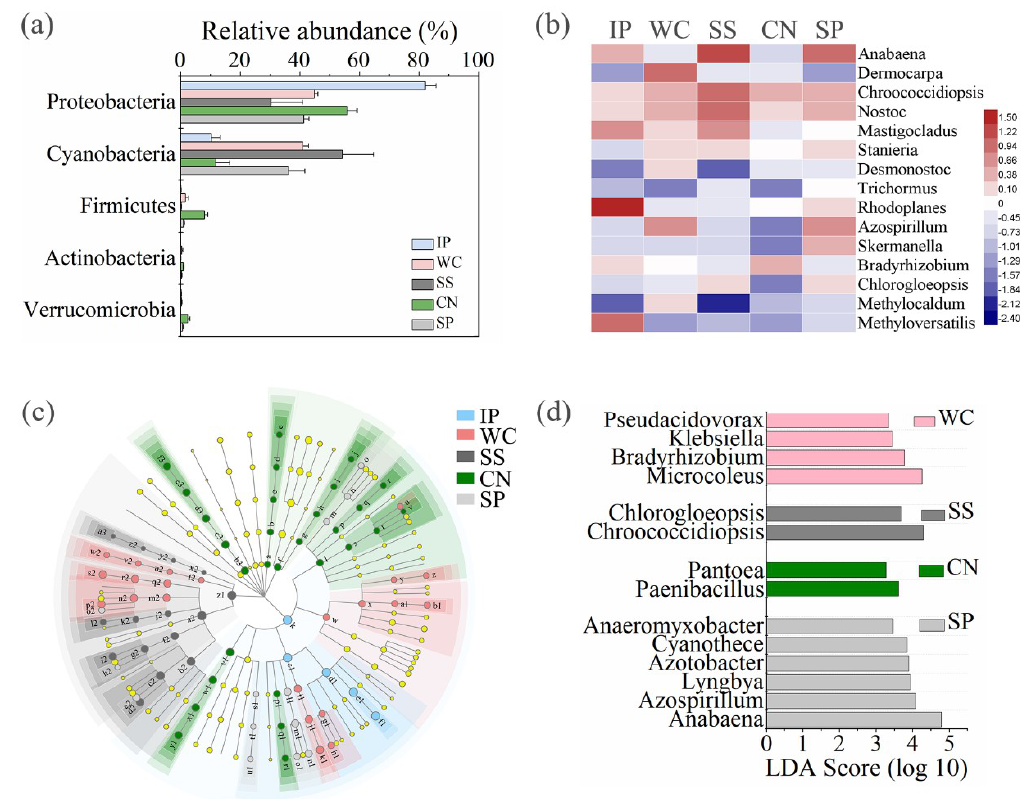
Figure 6. The relative abundances of diazotrophs at phylum level of five di ff erent phyllosphere samples ( a ). Heatmap of shared diazotrophic genera between the five phyllosphere samples ( b ). Taxonomic di ff erences among di ff erent phyllosphere samples by a linear discriminant analysis (LDA) coupled with e ff ect size (LEfSe). Taxonomic representation of statistically and biologically consistent di ff erences among di ff erent phyllosphere samples ( c ). LDA scores were calculated by the LDA e ff ect size, using the linear discriminant analysis to assess the e ff ect size for each di ff erential genera with relative abundance of the taxa comprising more than 0.1% of the diazotrophic sequences in each sample ( d ). IP indicates Ipomoea pes-caprae , WC indicates Wedelia chinensis , SS indicates Scaevola sericea , CN indicates Cocos nucifera , SP indicates Sesuvium portulacastrum